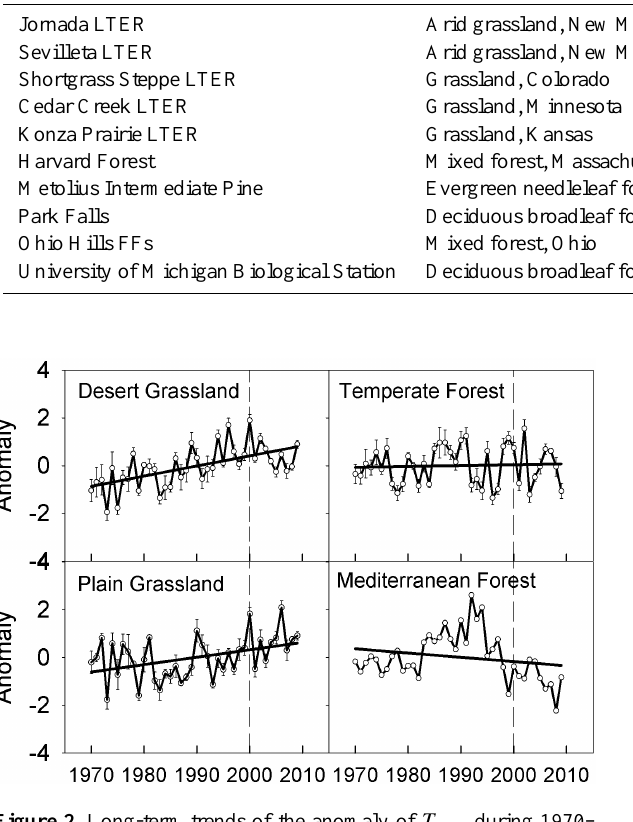
Figure 2. Long-term trends of the anomaly of T max during 1970– 2009 for different biome types. DG, arid grassland sites (DE, JE, WG, SR, and CP in Table 1); MG, mesic grassland sites (SP and LW in Table 1); TF, temperate forested sites (LR, MC, BC, and CF in Table 1); MF, Mediterranean forested site (CC). The dotted line shows the year of 2000 for the starting year of the MODIS EVI data